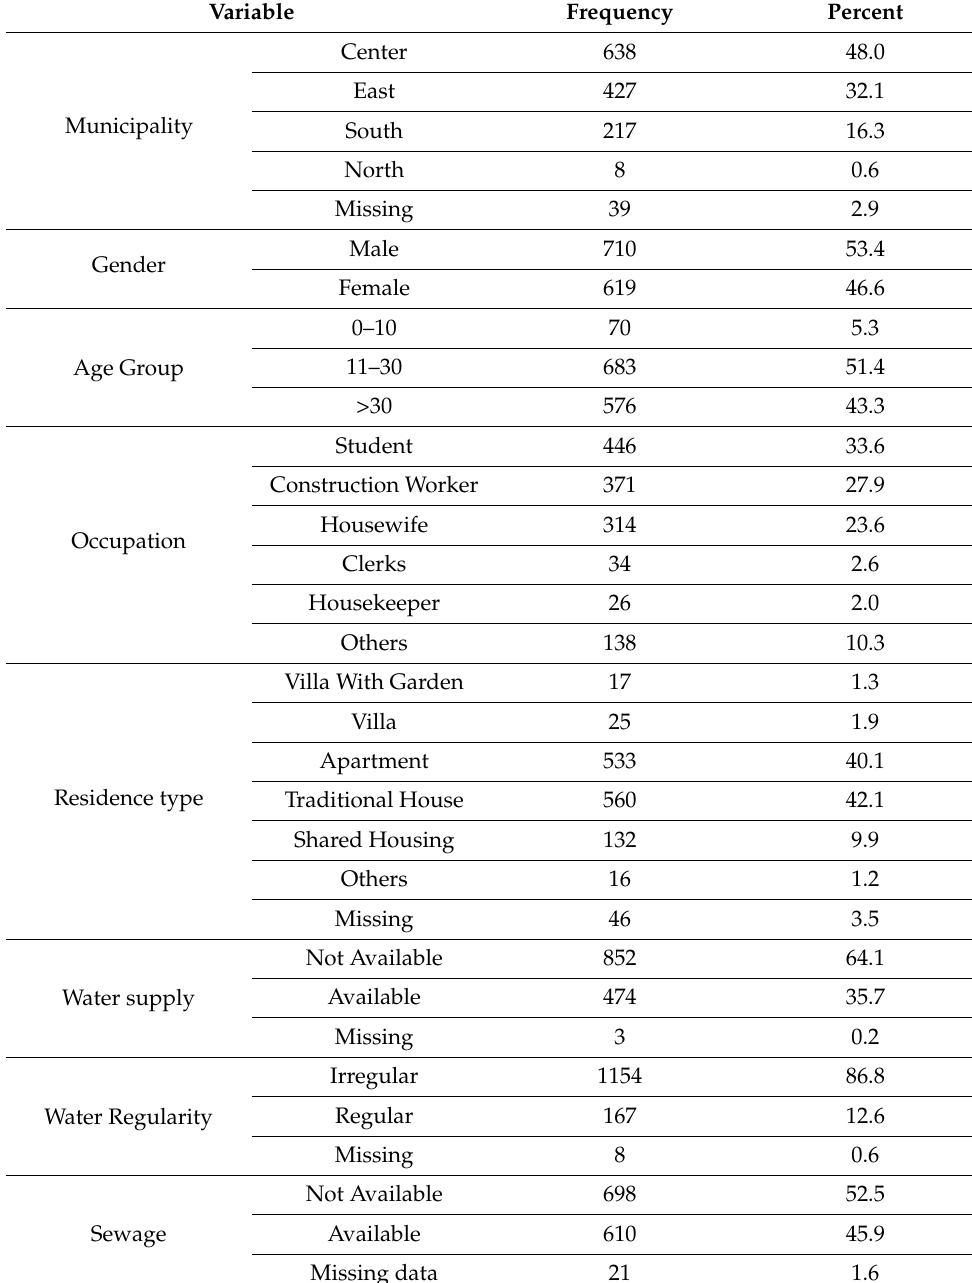
Table 1. Sociodemographic and environmental characteristics of study